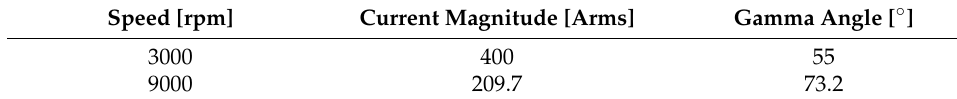
Table 4. Current magnitude and phase (gamma) angle at peak power for two speeds.